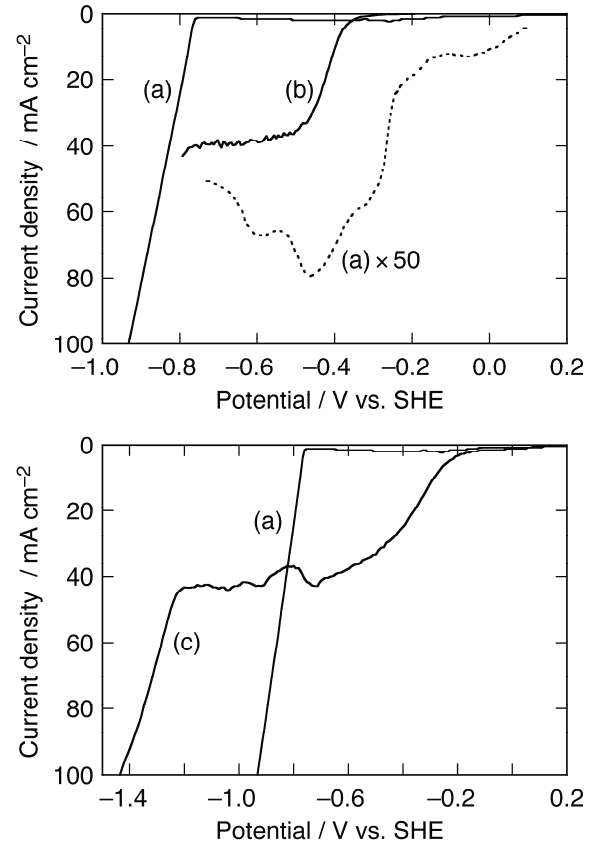
Figure 3. Cathodic polarization curves (sweep rate 5 mV s (cid:3) 1 / for the ammoniacal solutions ([NH 3 ] total D [NH 3 ] C [NH C ] D 5.0 M, pH 10.7, 343 K) containing (a) 4 60 mM Cd(II) and 10 mM Te(IV), (b) 10 mM Te(IV), and (c) 60 mM Zn(II) and 10 mM Te(IV). Working